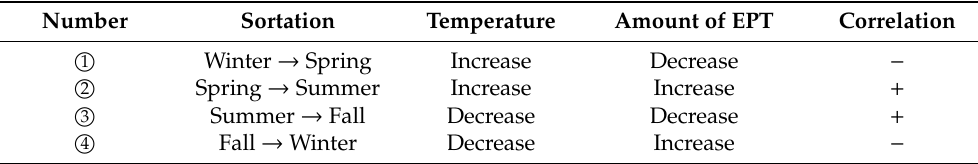
Table 3. Correlation between amount of EPT and temperature.